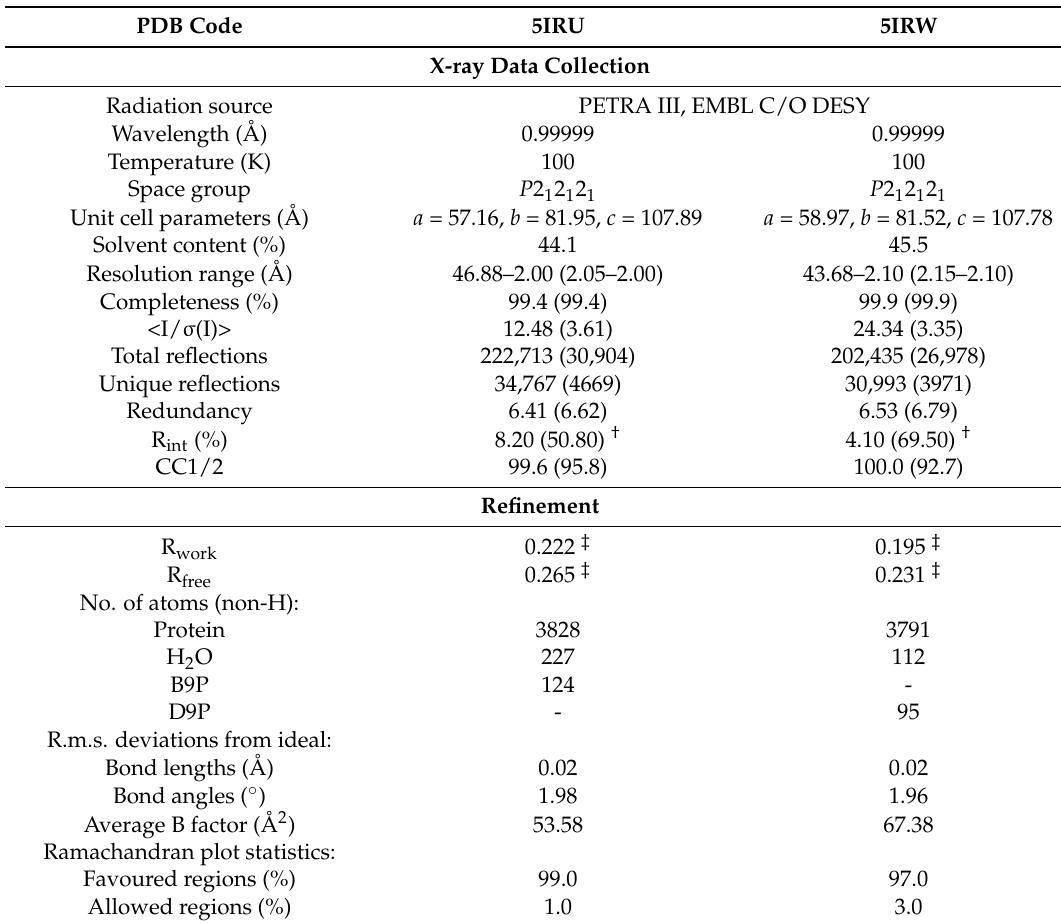
Table 2. X-ray data collection and crystal structure refinement statistics. Values in parentheses are for the last resolution